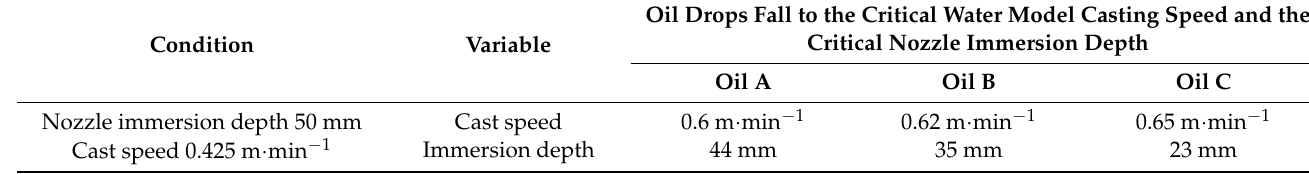
Table 4. Critical condition of oil droplets with different silicone oil